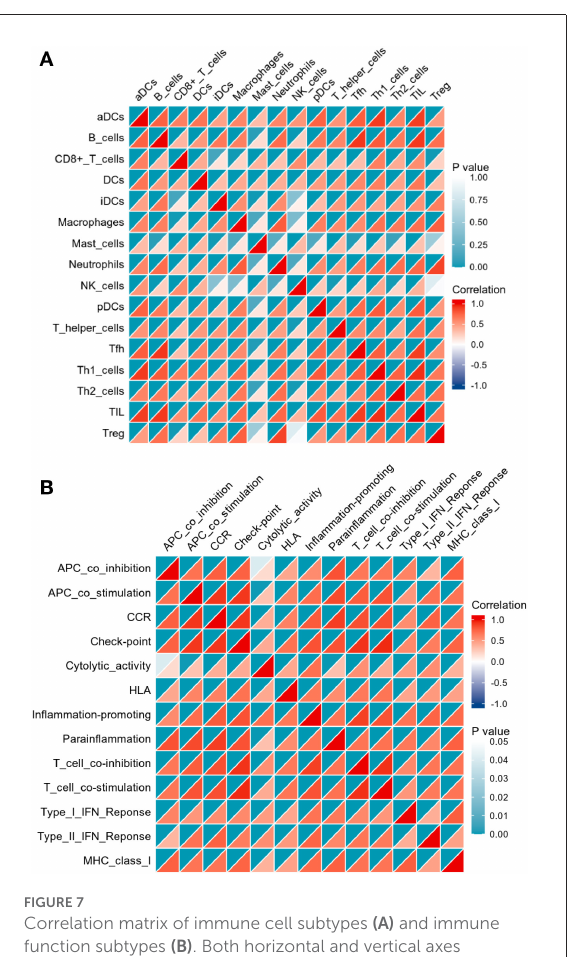
FIGURE7 Correlation matrix of immune cell subtypes (A) and immune function subtypes (B) . Both horizontal and vertical axes demonstrate immune cell subtypes and immune function subtypes (blue for negative correlation, white for weak or no correlation), red for positive correlation). Color represents the significance, increasing gradually from white to